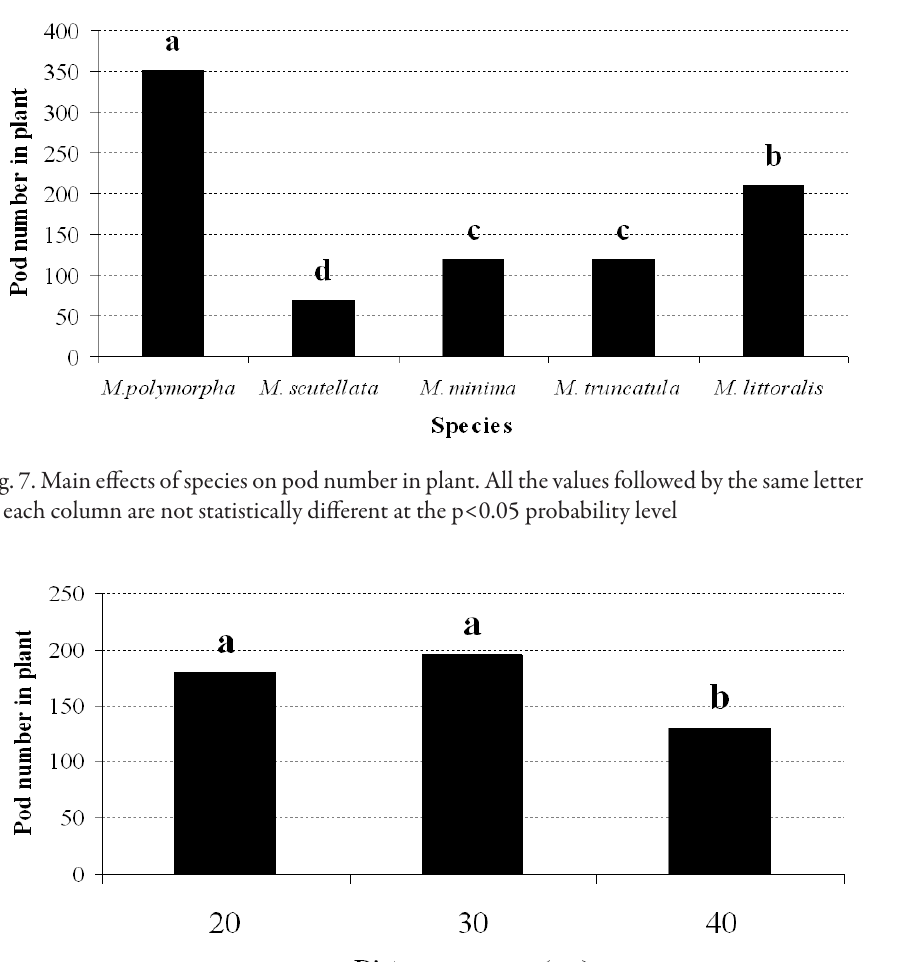
Fig. 6. Main effects of within row spacing on pod yield. All the values followed by the same letter in each column are not statistically different at the p<0.05 probability level